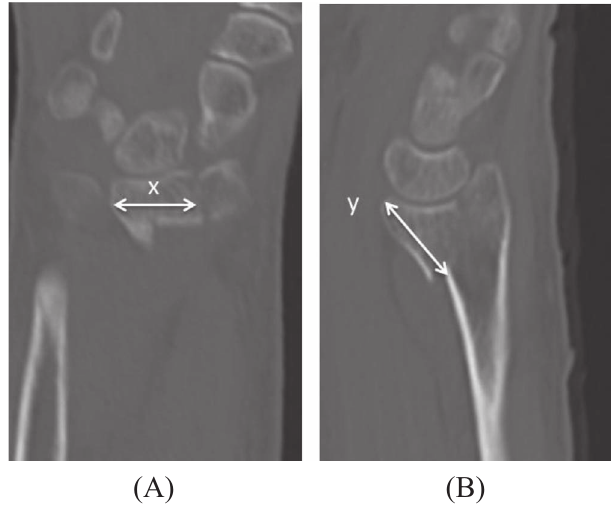
Figure 1. Transverse dimension of the VLF was measured where the distance from radioulnar joint to the radial aspect of fracture line of the VLF was maximum in the CT coronal plane (x) (1A). After the volar tip of the distal radius was identi fi ed in the CT axial plane the longitudinal dimension of the VLF was measured at the same point in the CT sagittal plane (y)